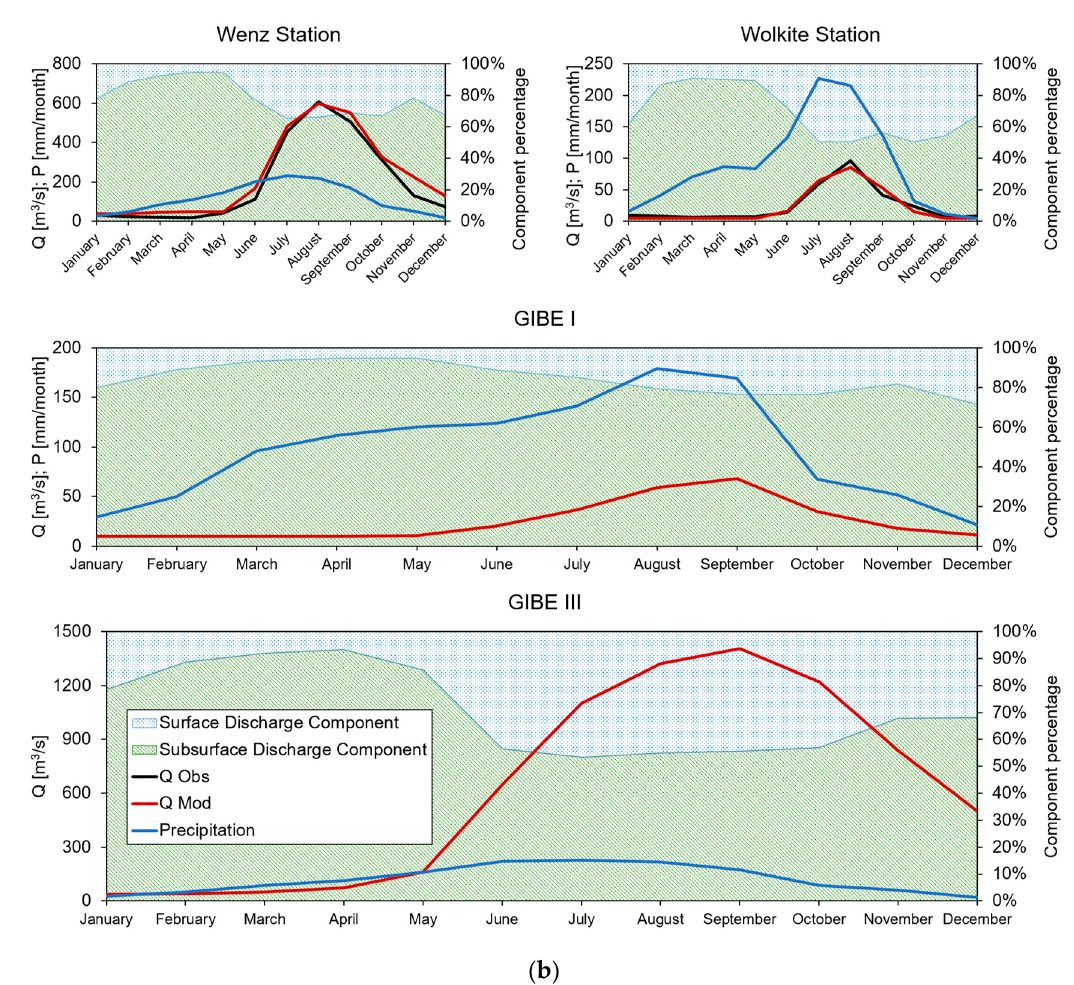
Figure 3. Monthly flows during the calibration period (1965–1988), at dam sites and river discharge stations. ( a ) Blue Nile basin, GERD. ( b ) Omo basin, GIBE. We also report flow components (surface/subsurface).